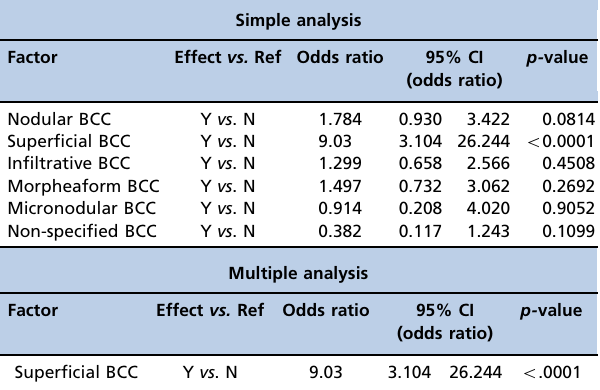
Table 4 - The logistic regression results used to evaluate the association between the histologic diagnosis and number of